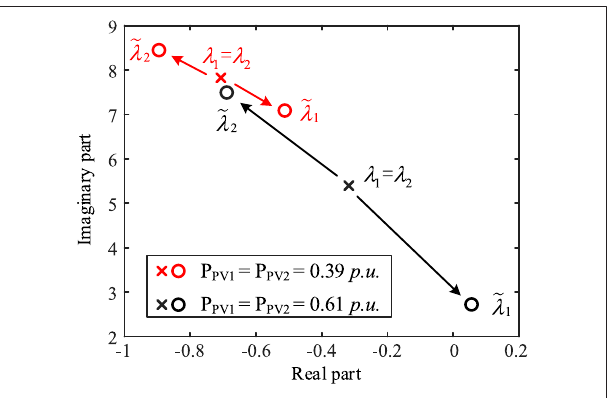
FIGURE 8 | OLMR phenomenon of λ 1 and λ 2 when PV power generation varies.